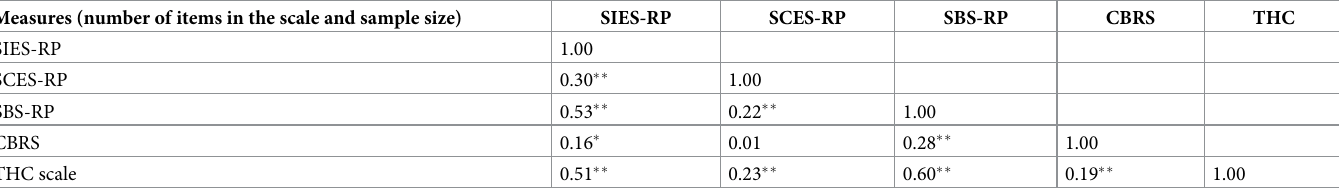
Table 4. Correlation matrix of among scale school